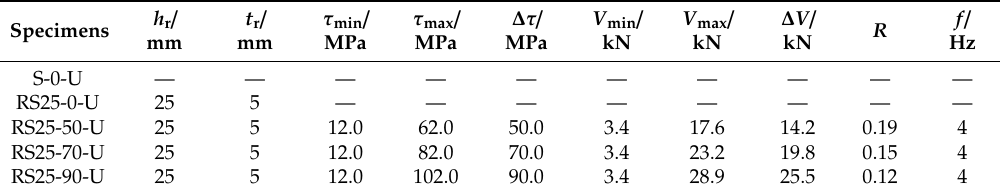
Table 1. Summary of push-out specimens.